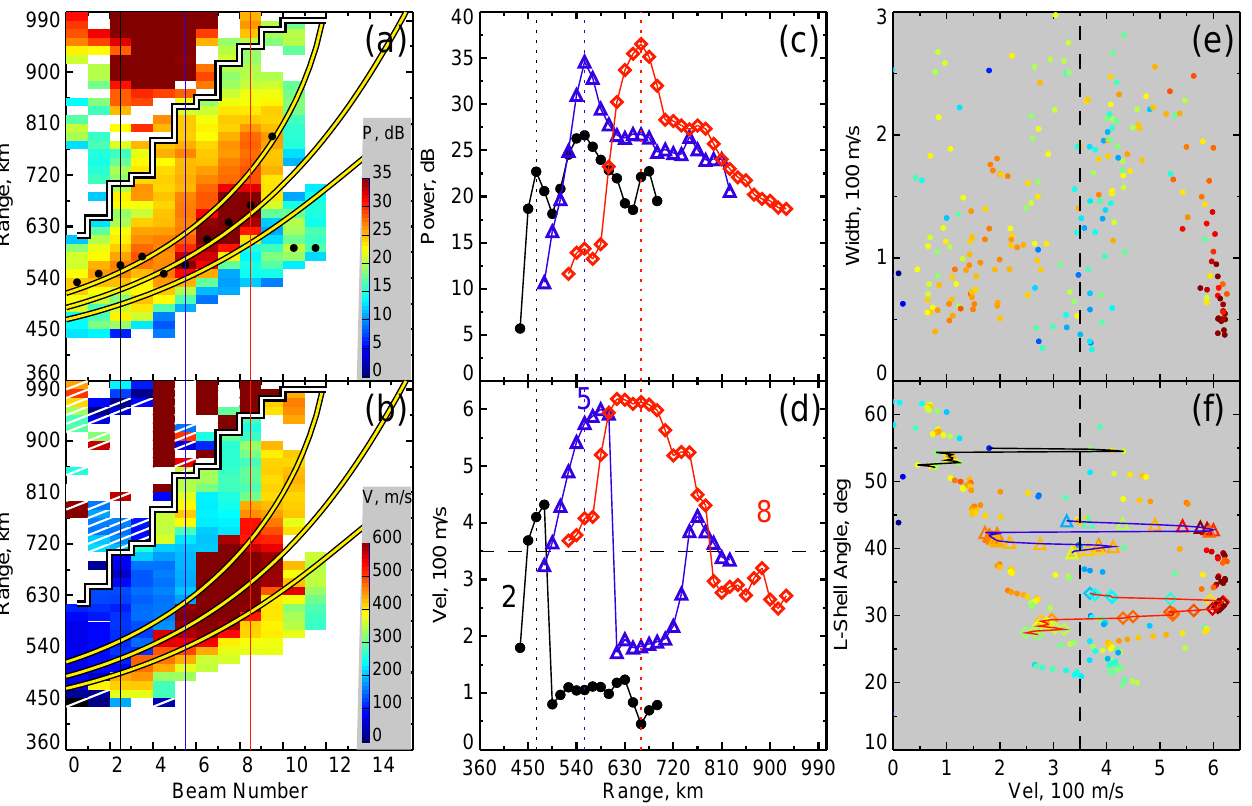
Fig. 3. The same as Fig. 2 but for 03:30–03:32UT and with the reversal in velocity polarity in panels (b) , (d) , and (f) .